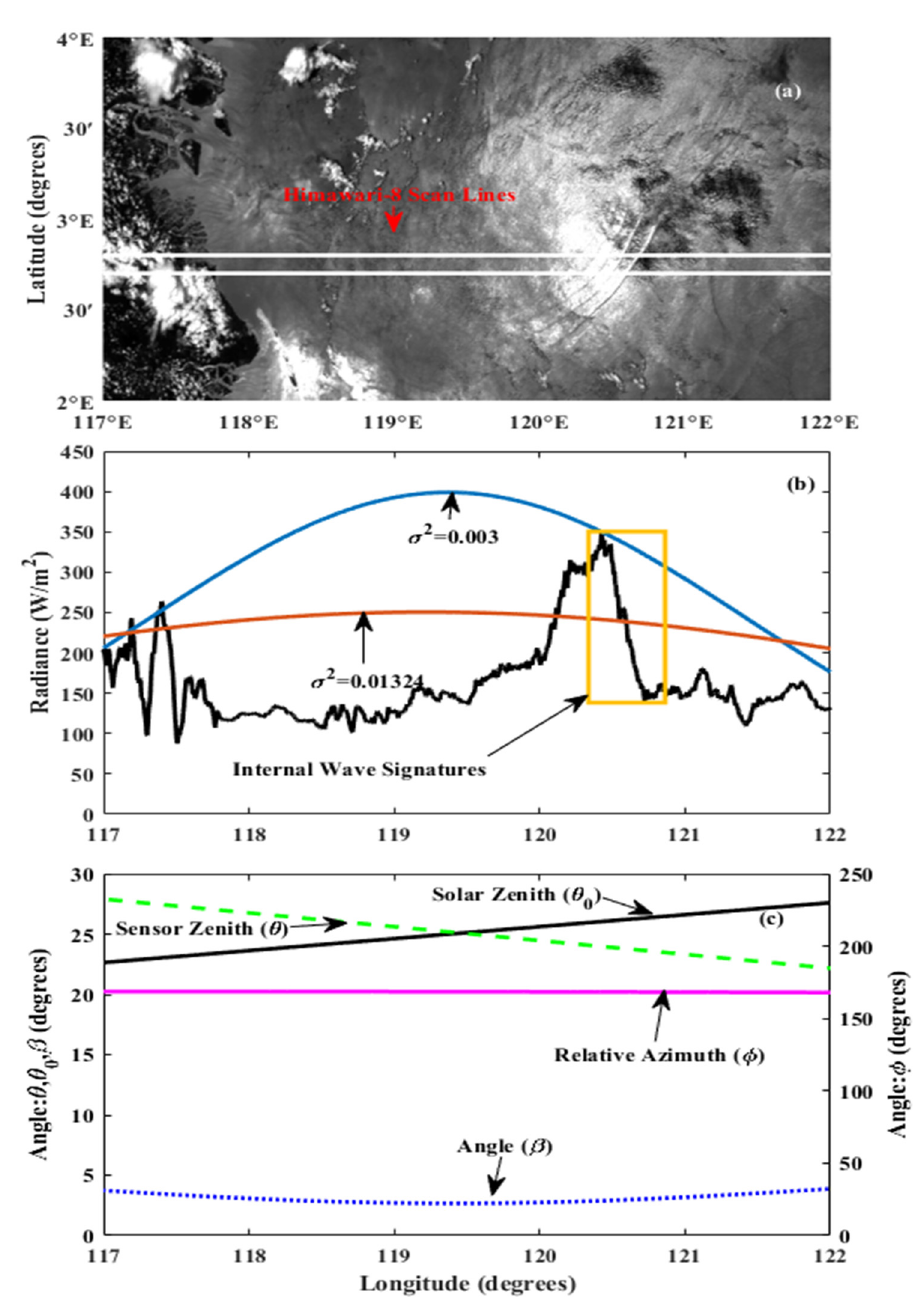
Figure 11. Analysis of the image acquired on 21 September 2020 at 05:30 UTC. ( a ) shows part of the Himawari-8 image of the Celebes Sea acquired on 21 September 2020 at 05:30 UTC, and the white solid line represents the scan line of the AHI sensor onboard the Himawari-8 satellite; ( b ) shows curves of the normalized solar radiance calculated with roughness variance ( σ 2 ) values of 0.003 and 0.01324 and the average measured radiance along the scan line, and the yellow box marks the position of the internal solitary waves. The blue and orange curves indicate the radiance information of the sea surface background and internal solitary waves, respectively; ( c ) shows the changes in the solar zenith angle ( θ 0 ), sensor zenith angle ( θ ), relative azimuth angle ( ϕ ), and surface facet tilt ( ꞵ ) along the AHI sensor scan line. The solid black line indicates the change in the solar zenith angle ( θ 0 ) along the scan line. The green dashed line indicates the change in the sensor zenith angle ( θ ) along the scan line. The purple solid line indicates the relative azimuth angle ( ϕ ) along the scan line. The blue dotted line indicates the change in surface facet tilt ( ꞵ ) along the scan line.